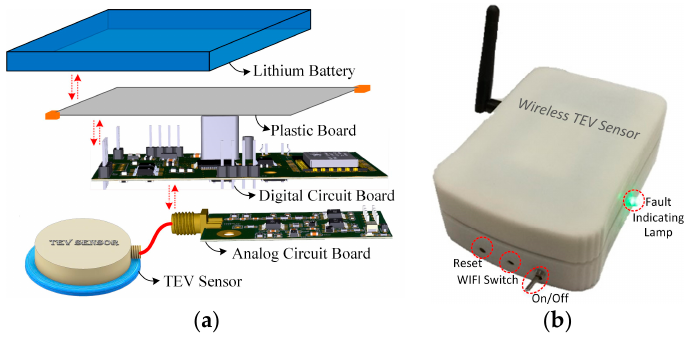
Figure 11. Wireless TEV sensor: ( a ) structural design diagram; and ( b ) physical picture.